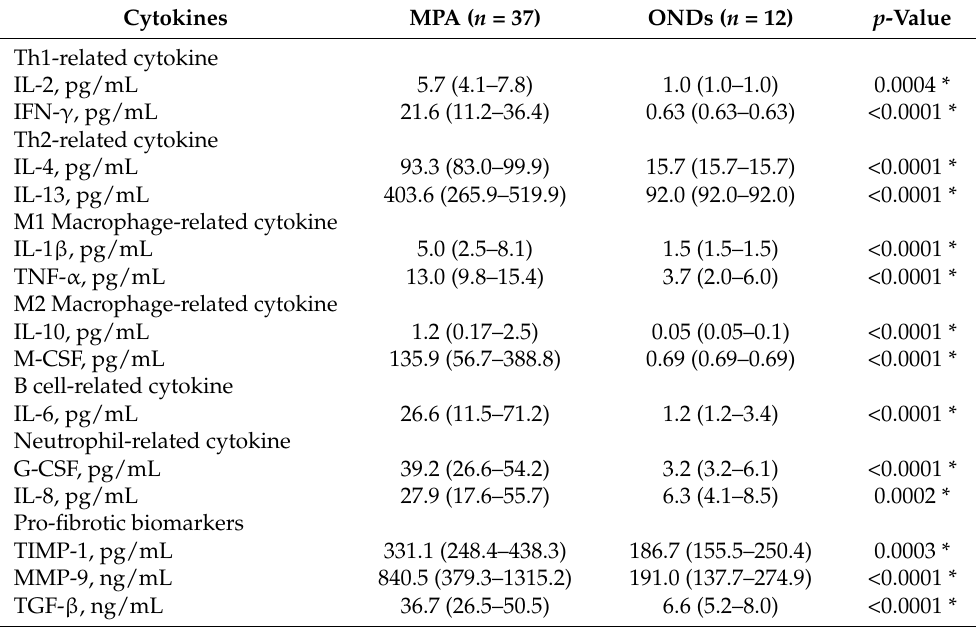
Table 3. Comparison of the cytokine levels between patients with MPA and patients with